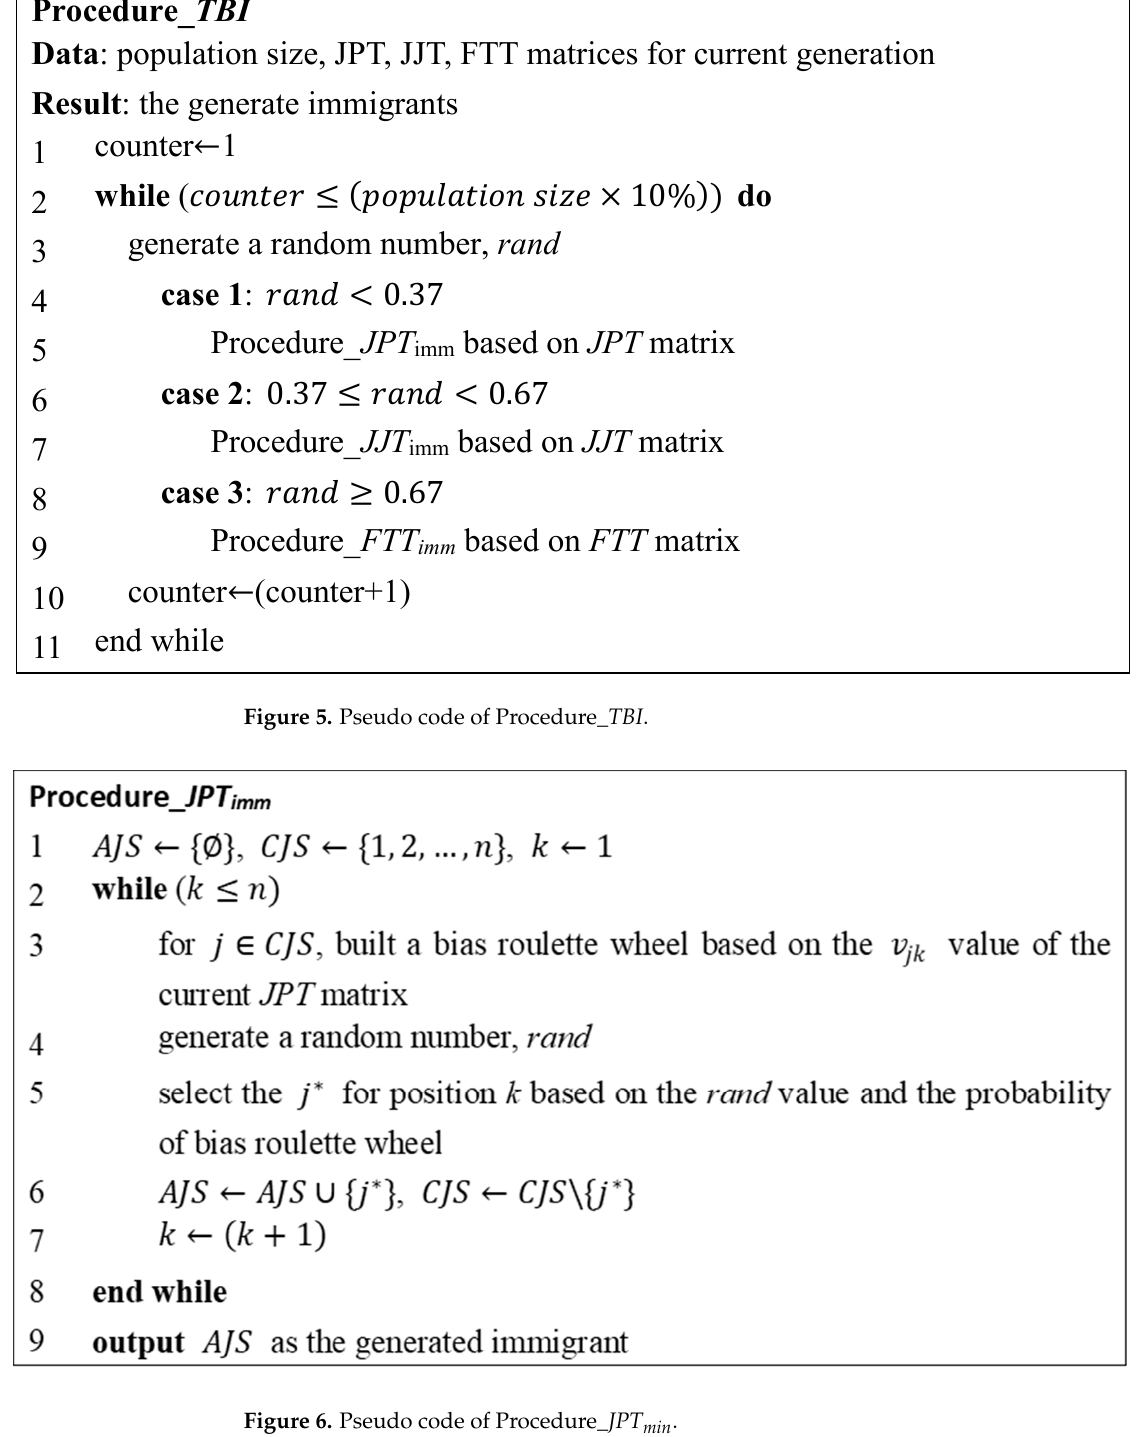
Figure 6. Pseudo code of Procedure_ JPT min.